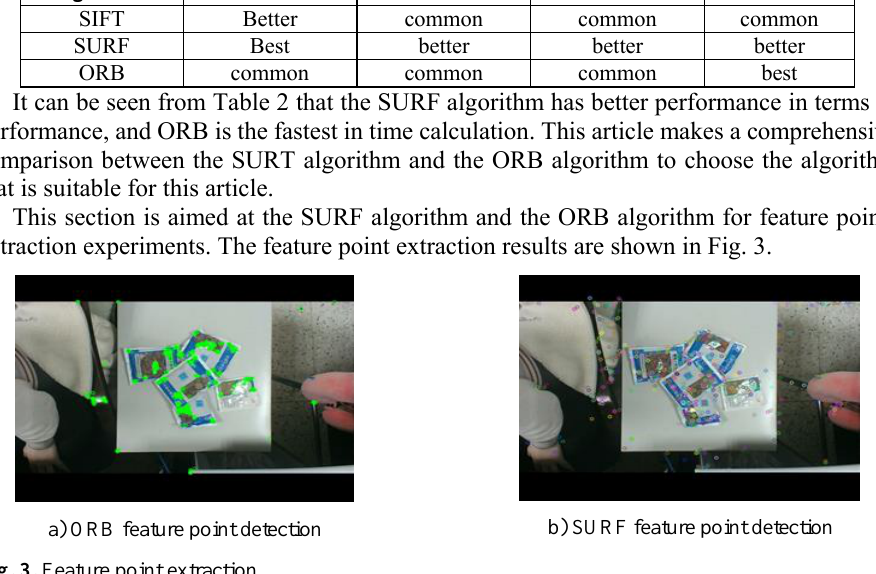
Fig. 3. Feature point